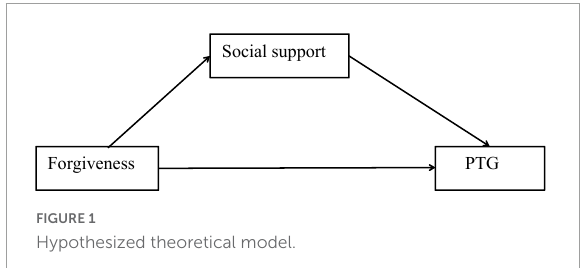
FIGURE1 Hypothesized theoretical